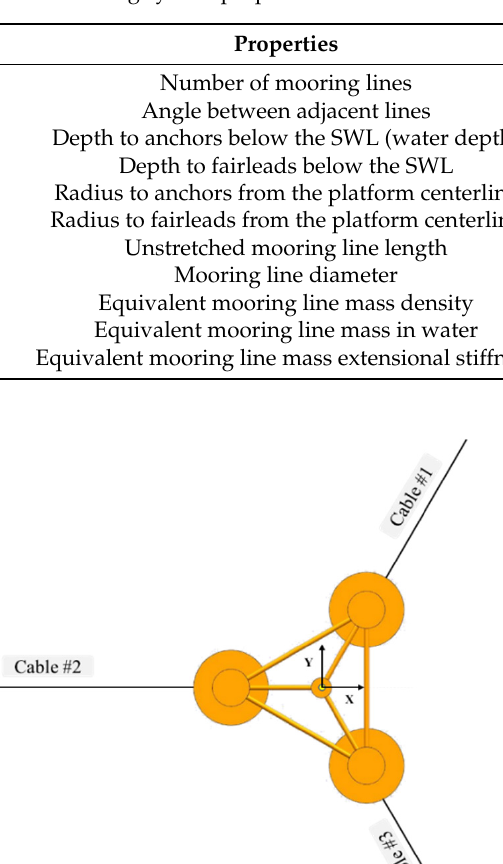
Table 2. Mooring system properties.